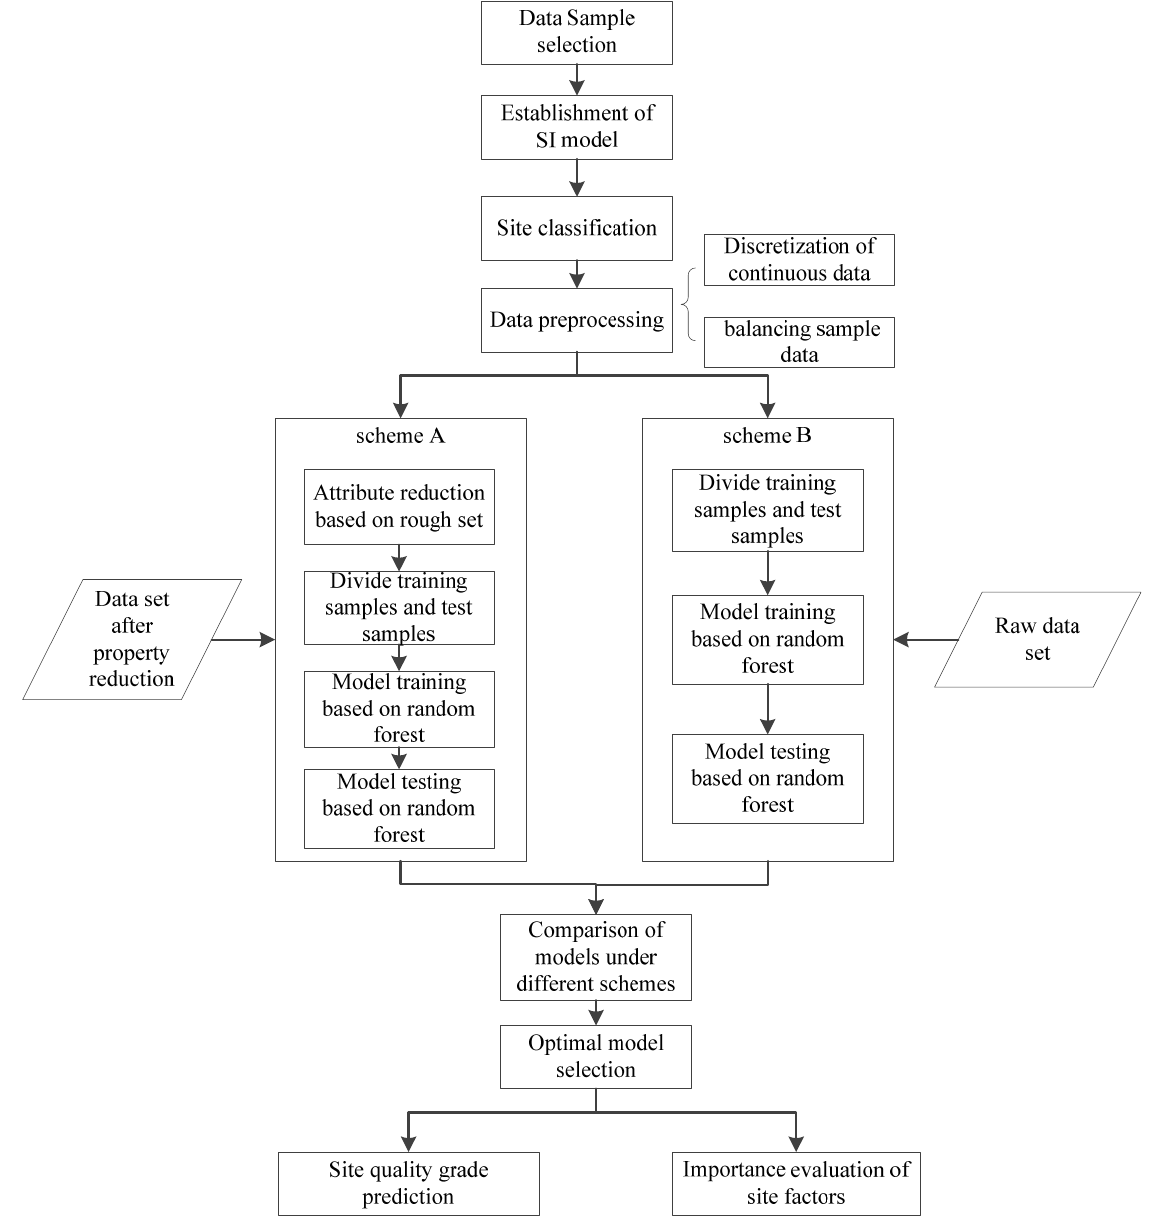
Figure 1. The flowchart of the modeling process.